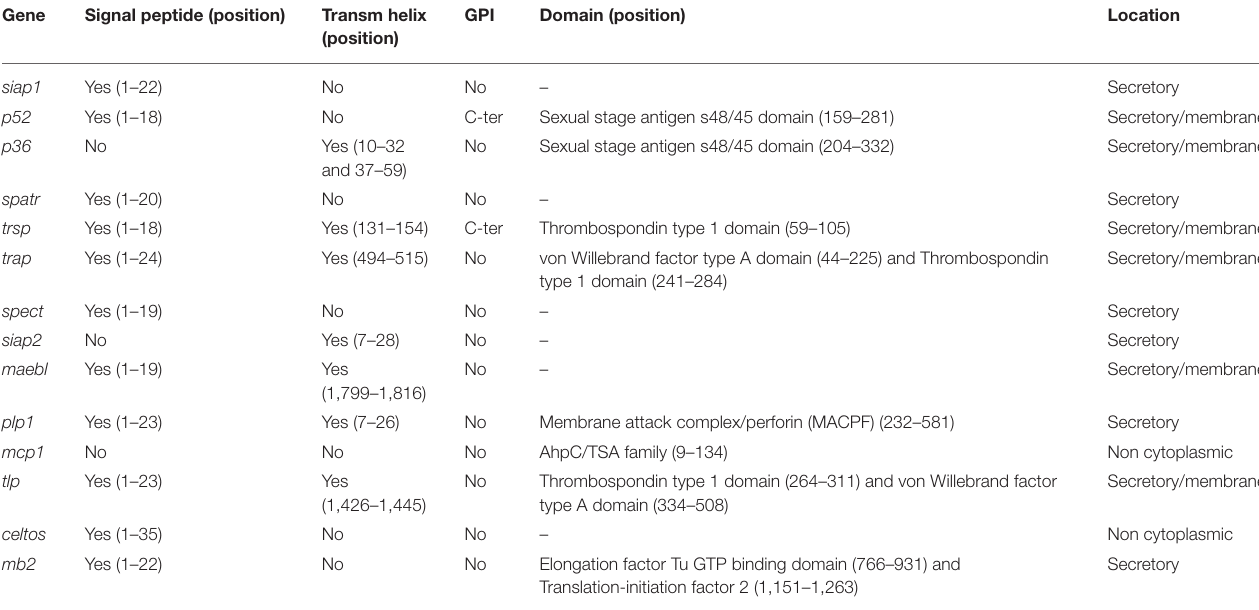
TABLE 1 | In silico characterization of 14 P. vivax sporozoite proteins. Gene Signal peptide (position) Transm helix (position)